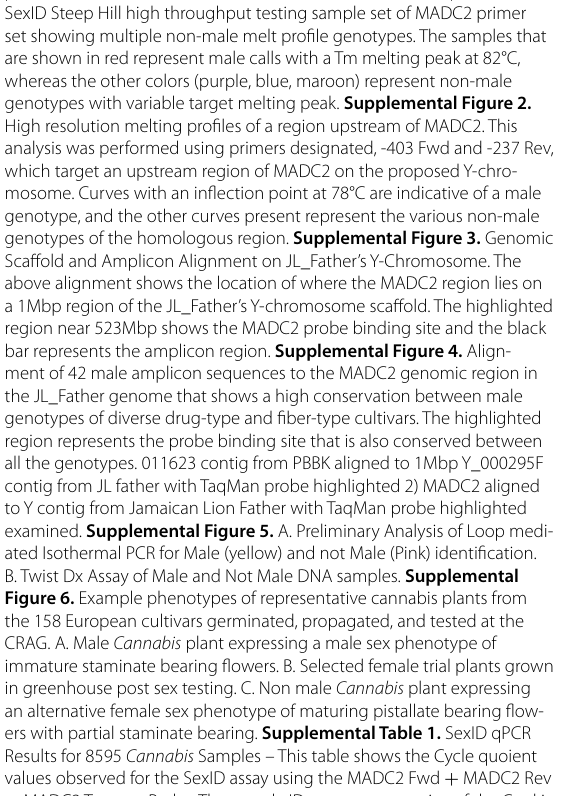
Figure 6. Example phenotypes of representative cannabis plants from the 158 European cultivars germinated, propagated, and tested at